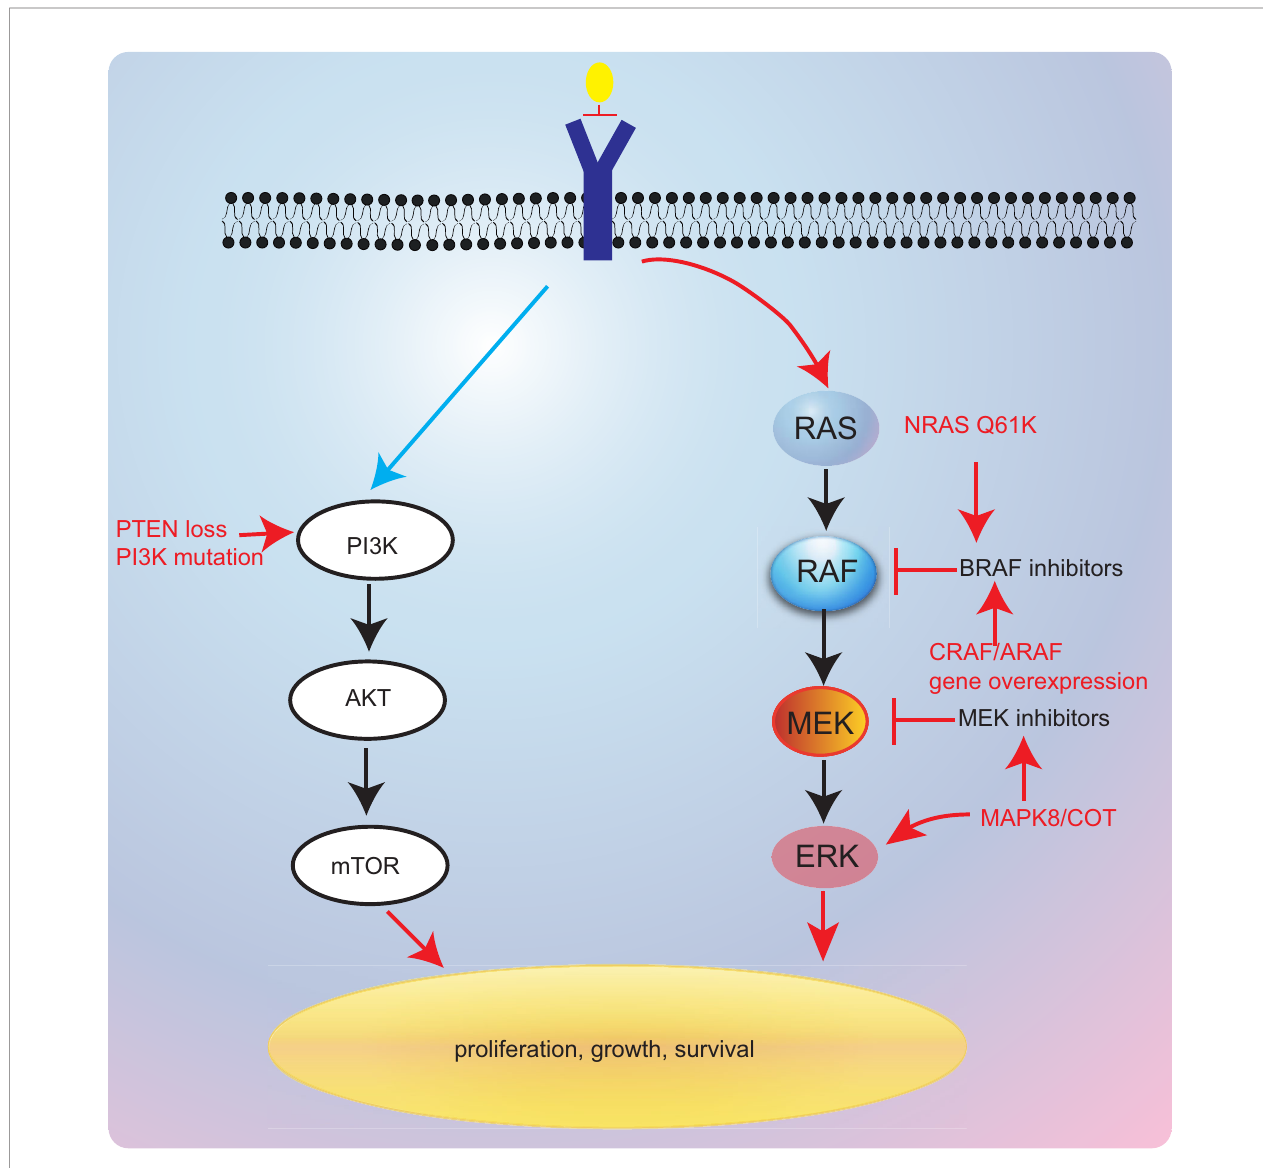
FIGURE 3 | Resistance mechanisms of targeted